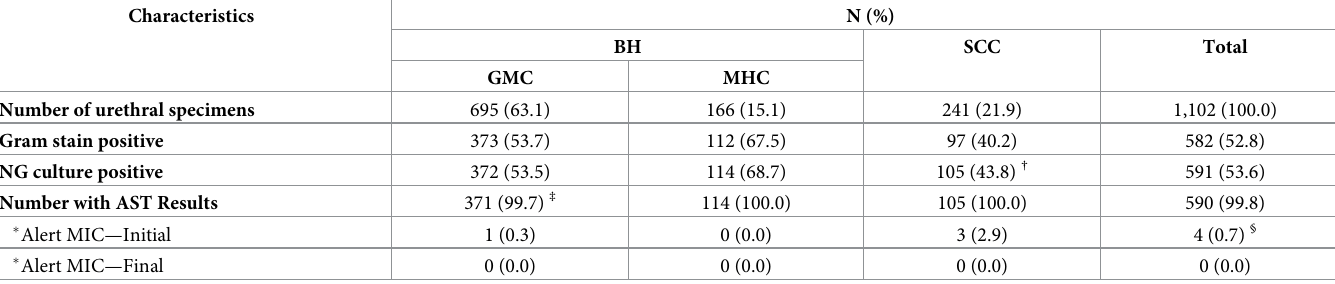
Table 1. Characteristics of collected urethral specimens from men with urethritis, EGASP Thailand, November 2015 –October 2016 (n = 1,102).